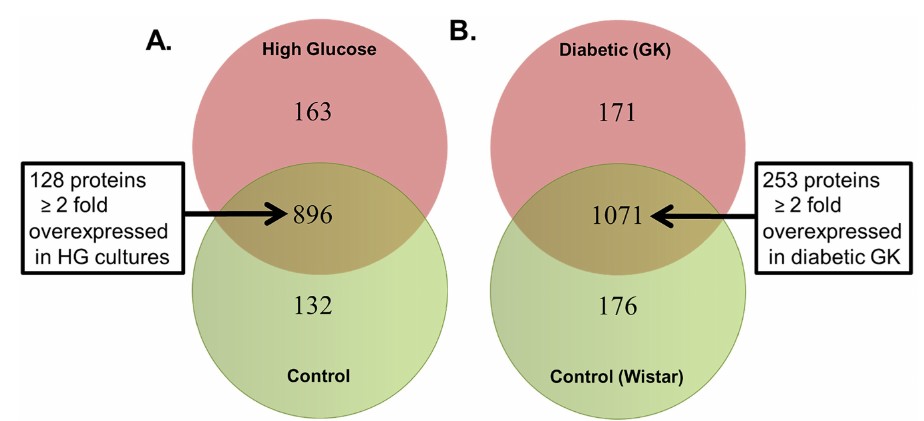
Fig 9. Proteomic comparison of Wistar rats, GK rats and the H9C2 cell line. (a) Commonly and exclusively quantified proteins in H9C2 cells fed either Normal Glucose or High Glucose concentration. (b) Commonly and exclusively quantified proteins in cardiac tissue from GK or Wistar